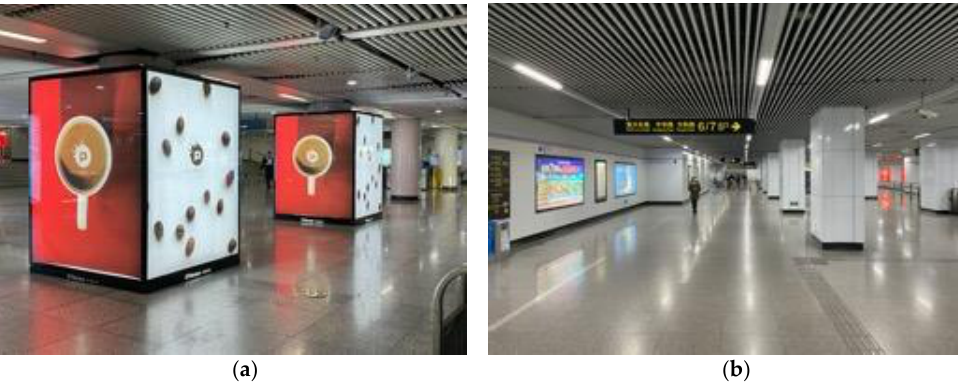
Figure 17. Sample station transfer space environment aesthetic status problems: ( a ) Unreasonable advertising layout; ( b ) single and tedious space. Images courtesy of the author.